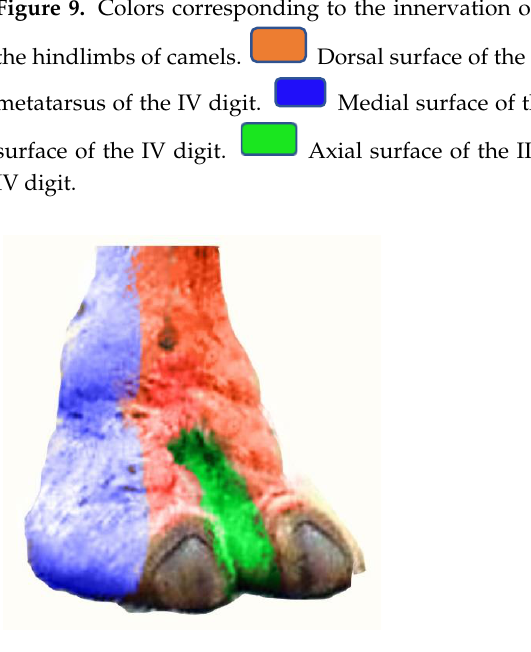
Figure 10. Color corresponding to innervation of the III and IV digits. Lateral and latero-plan- tar aspect innervation by the abaxial lateral tibial nerve of the III and IV digits. Dorsal aspect innervation by the superficial fibular nerve of the III and IV digits. Medial and medio-plantar aspect innervation by the axial medial tibial nerve of the III and IV digits.